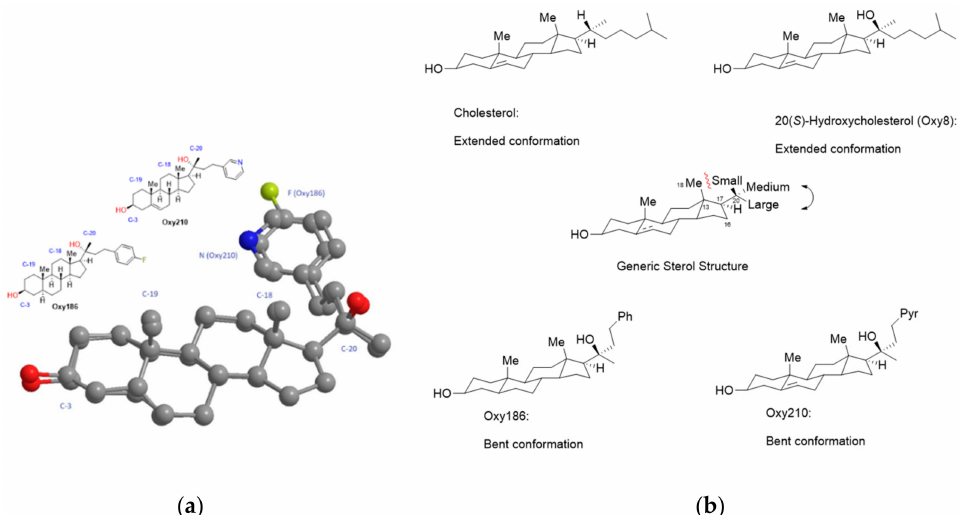
Figure 12. Conformational properties of Oxy186 and Oxy210 ( a ) The molecular structures of Oxy186 and Oxy210 and an overlay of their crystal structures. A structure alignment algorithm (Mercury, The Cambridge Crystallographic Data Centre) determined the minimal root mean square deviation (RMSD) of atomic positions in the overlay to equal 0.221 Å. ( b ) Varying the substitution pattern and stereochemical configuration of the C17–C20 bond, can result in a preference for either an extended or bent conformation of the ‘Large’ substituent, usually the sterol side, with respect to the tetracyclic sterol